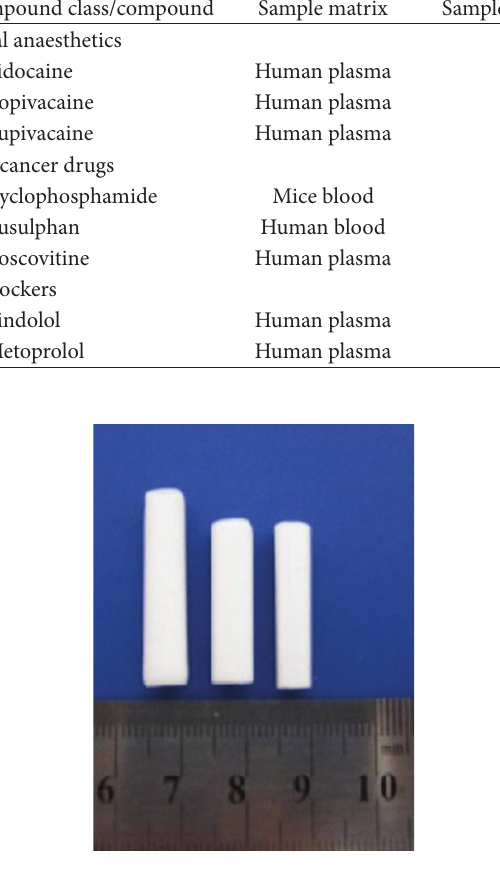
Figure 12: Photograph of different dimensions of SBSEM [118].